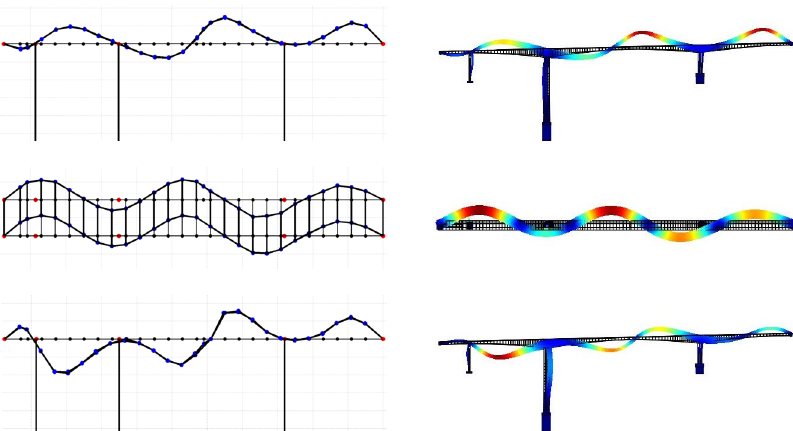
Figure A3. Comparison between the experimentally identified (left column) and nominal FE model predicted (right column) mode shapes of the Metsovo bridge. Modes